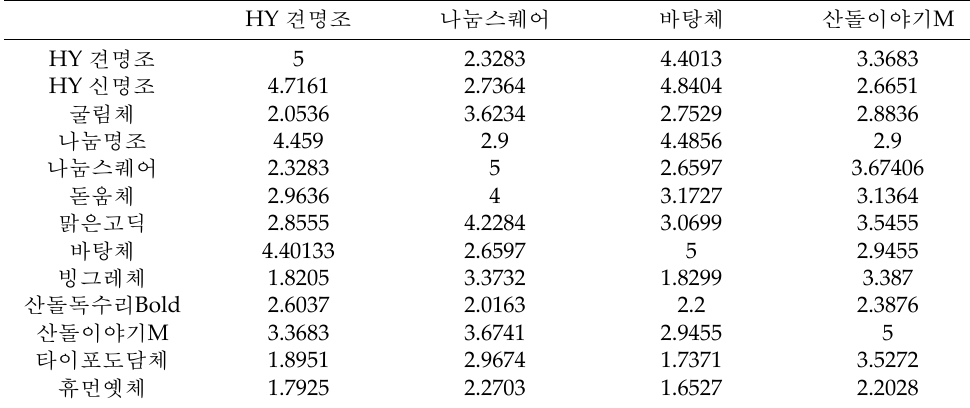
Table 8. Ground‑truth as a result of a medium font